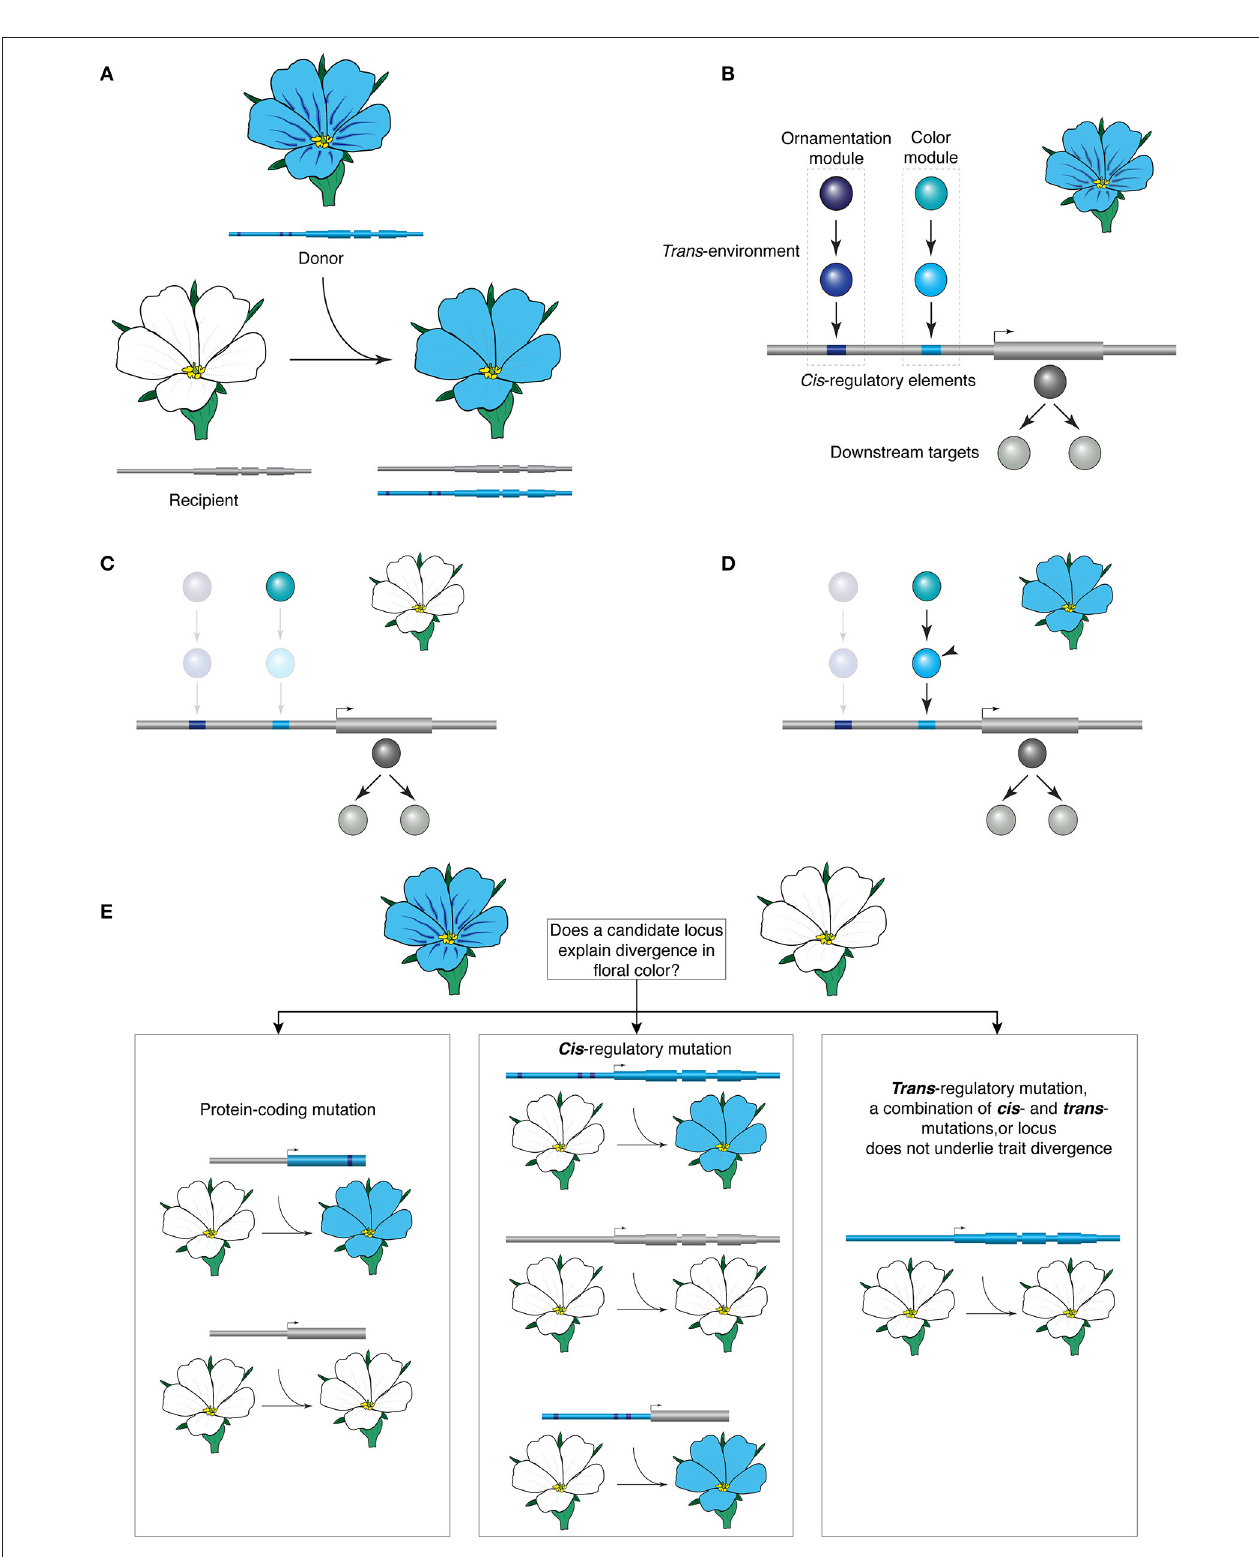
FIGURE 1 | The premise of interspecies gene transfer. (A) Transferring a locus from the blue-flowered donor species is able to transform the color of the white flowers of the recipient; note that the transfer does not recapitulate the ornamentation (the nectar guides) of the donor in the recipient. (B–D) Hypothetical network